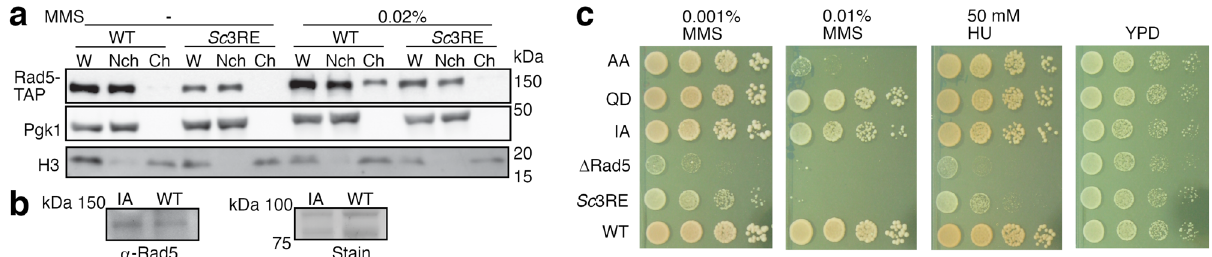
Fig. 5 Physiological function of the conserved and positively charged region in Rad5 ’ s HIRAN domain. a The Sc 3RE substitution abolishes MMS-induced Sc Rad5 – chromatin association. Fractions in chromatin sedimentation experiments are analyzed for Sc Rad5 with western blot. W whole-cell extract, Nch non-chromatin fraction, Ch chromatin fraction. Pgk1 and the histone protein H3 are included as markers for the non-chromatin and chromatin fractions, respectively. b The I916A substitution does not affect the Sc Rad5 protein level. The Sc Rad5 protein level is probed by western blot with an anti-Rad5 antibody. Equal loading was con fi rmed by Ponceau S staining (right panel). c The Sc 3RE substitution causes sensitivity to replication stress-causing agents MMS and HU. AA, D681A/E682A; IA, I916A; QD, Q1061D; Δ Rad5, Rad5 deletion; YPD, yeast extract peptone dextrose medium. For experiments presented in panels a – c , similar results were obtained using at least two independent strains per genotype. Source data for panels a , b are provided